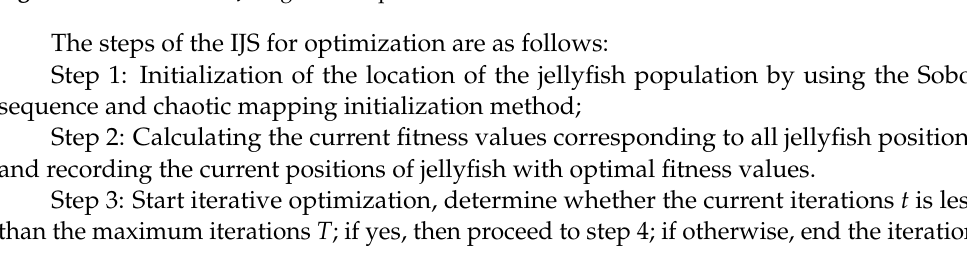
Figure 2. Flow chart of IJS algorithm